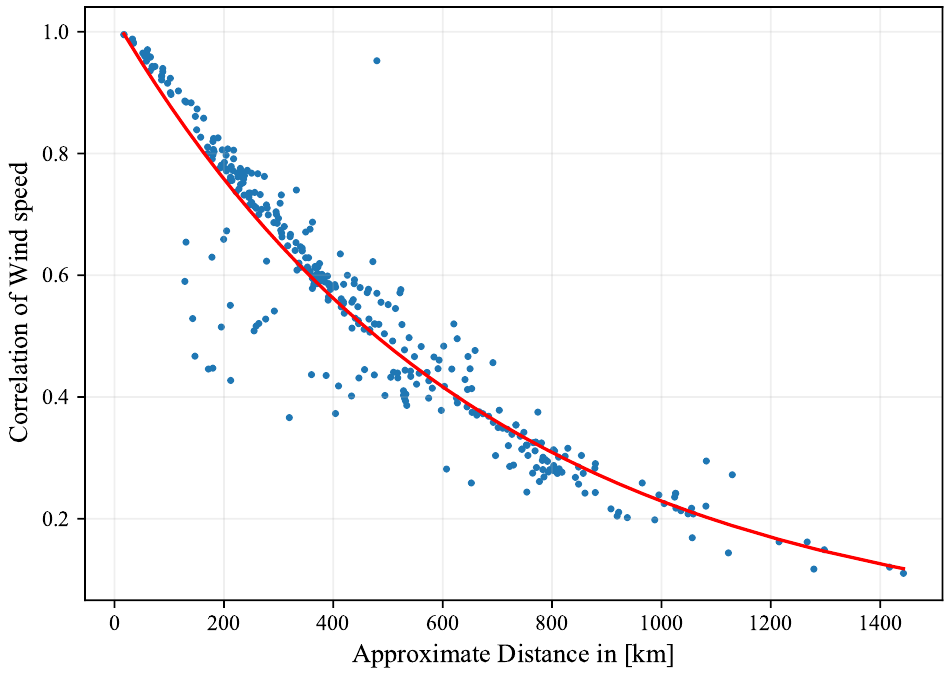
Figure 9. Pairwise correlation of wind speed vs. distance. Each point (blue) represents a pair of wind farms in the data. The best fitting exponential model ρ ∝ exp ( − distance / D ) is shown by the red